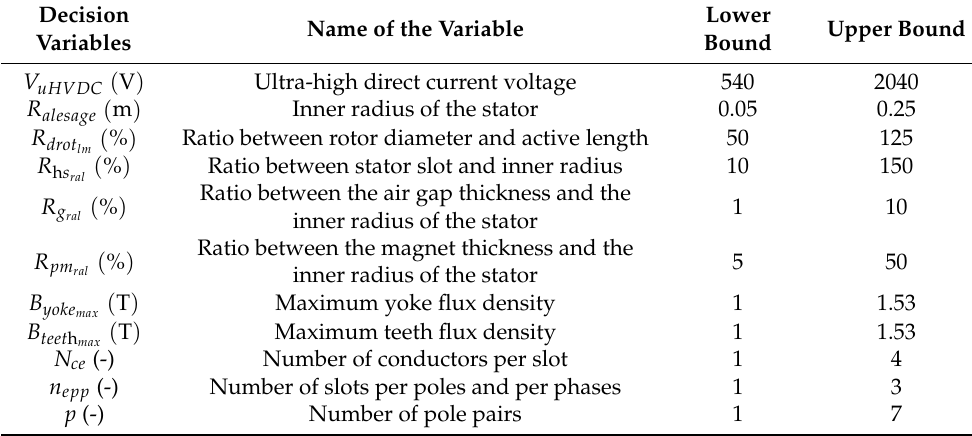
Table 12. Set of decision variables.